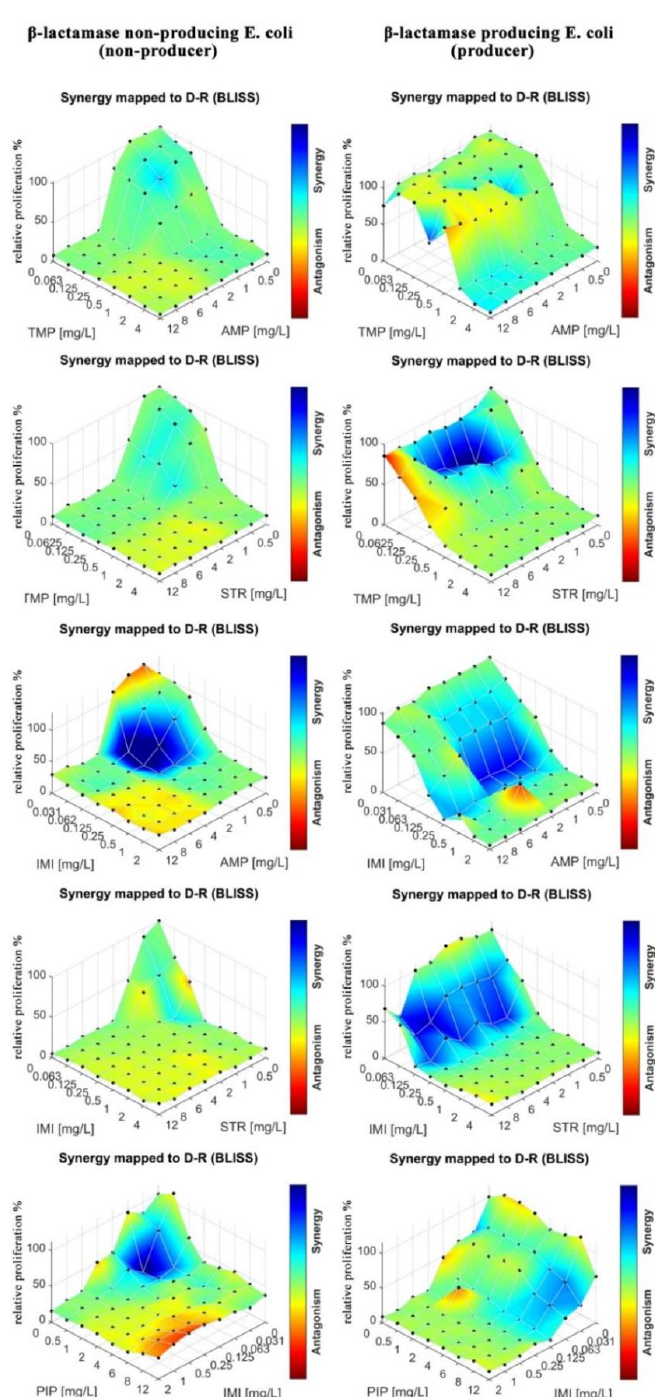
Figure 7. Relative proliferation of bacteria calculated as the ratio of the signal from the investigated well to the control well with bacteria without a drug; this was plated as a function of two drug concentrations in various combinations. Synergy scores overlapped over the proliferation map (blue–red color coding). Bacteria that do not produce beta-lactamase (non-producer) were placed next to the bacteria that do produce beta-lactamase (producer) for the same pair of tested antibiotics. Each map represents the results from a single mAST containing 4 experiment repetitions. More information can be found in the ESI.